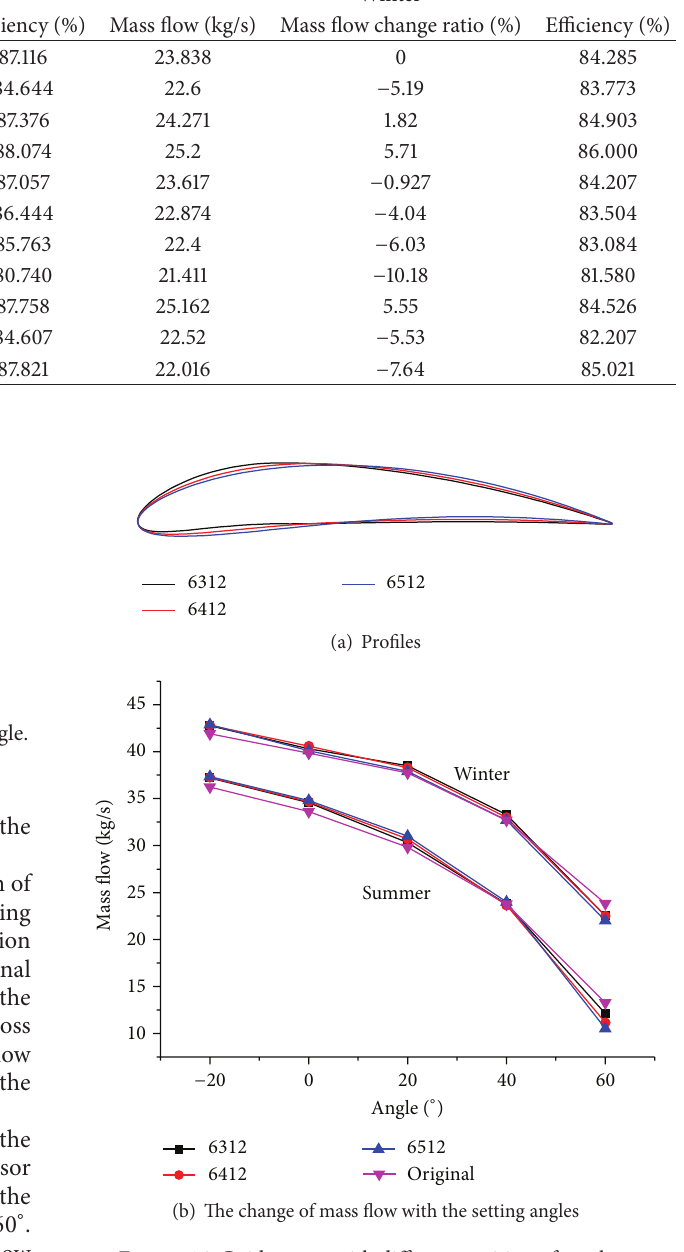
Figure 16: Guide vanes with different position of camber.